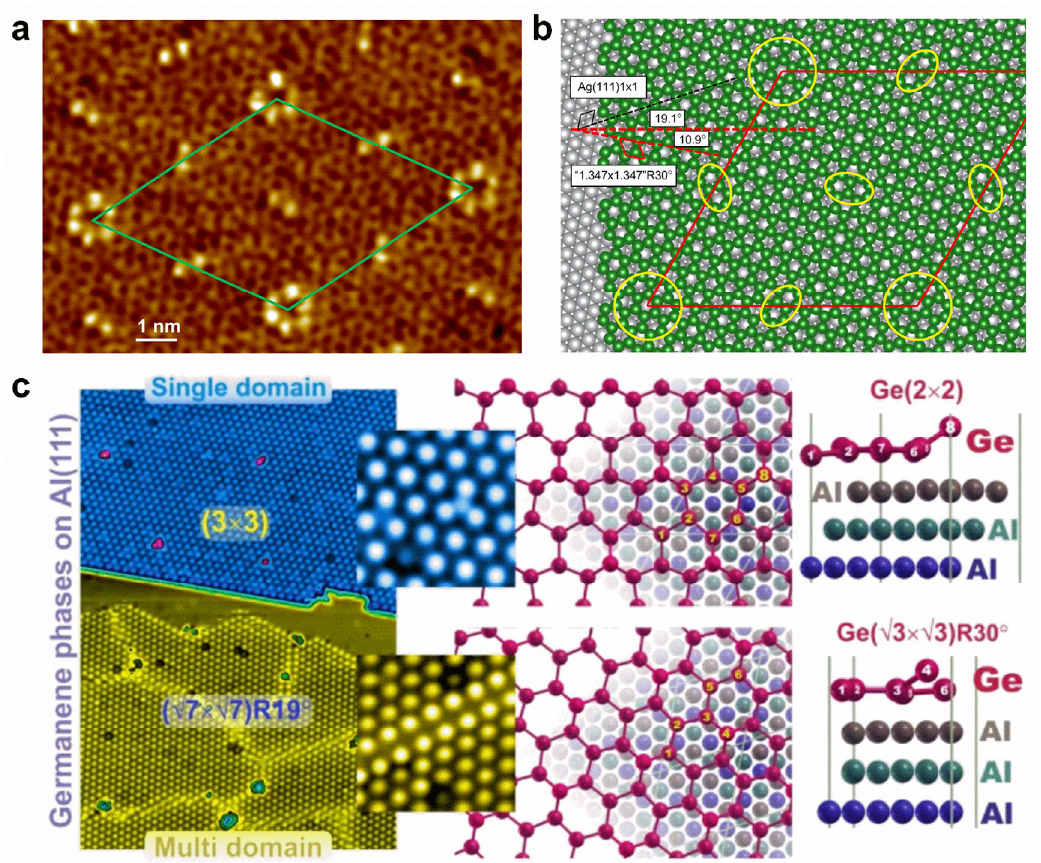
Figure 8. Surface modifications of germanene. ( a ) Atomic-scale STM image of germanene grown on a Ag(111) thin film. ( b ) Structural model of germanene on Ag(111). ( c ) Two different phases of germanene grown on an Al(111) surface. ( a , b ) Reprinted with permission from Ref. [151]. Copyright 2018, American Chemical Society. ( c ) Reprinted with permission from Ref. [152]. Copyright 2019, Springer Nature